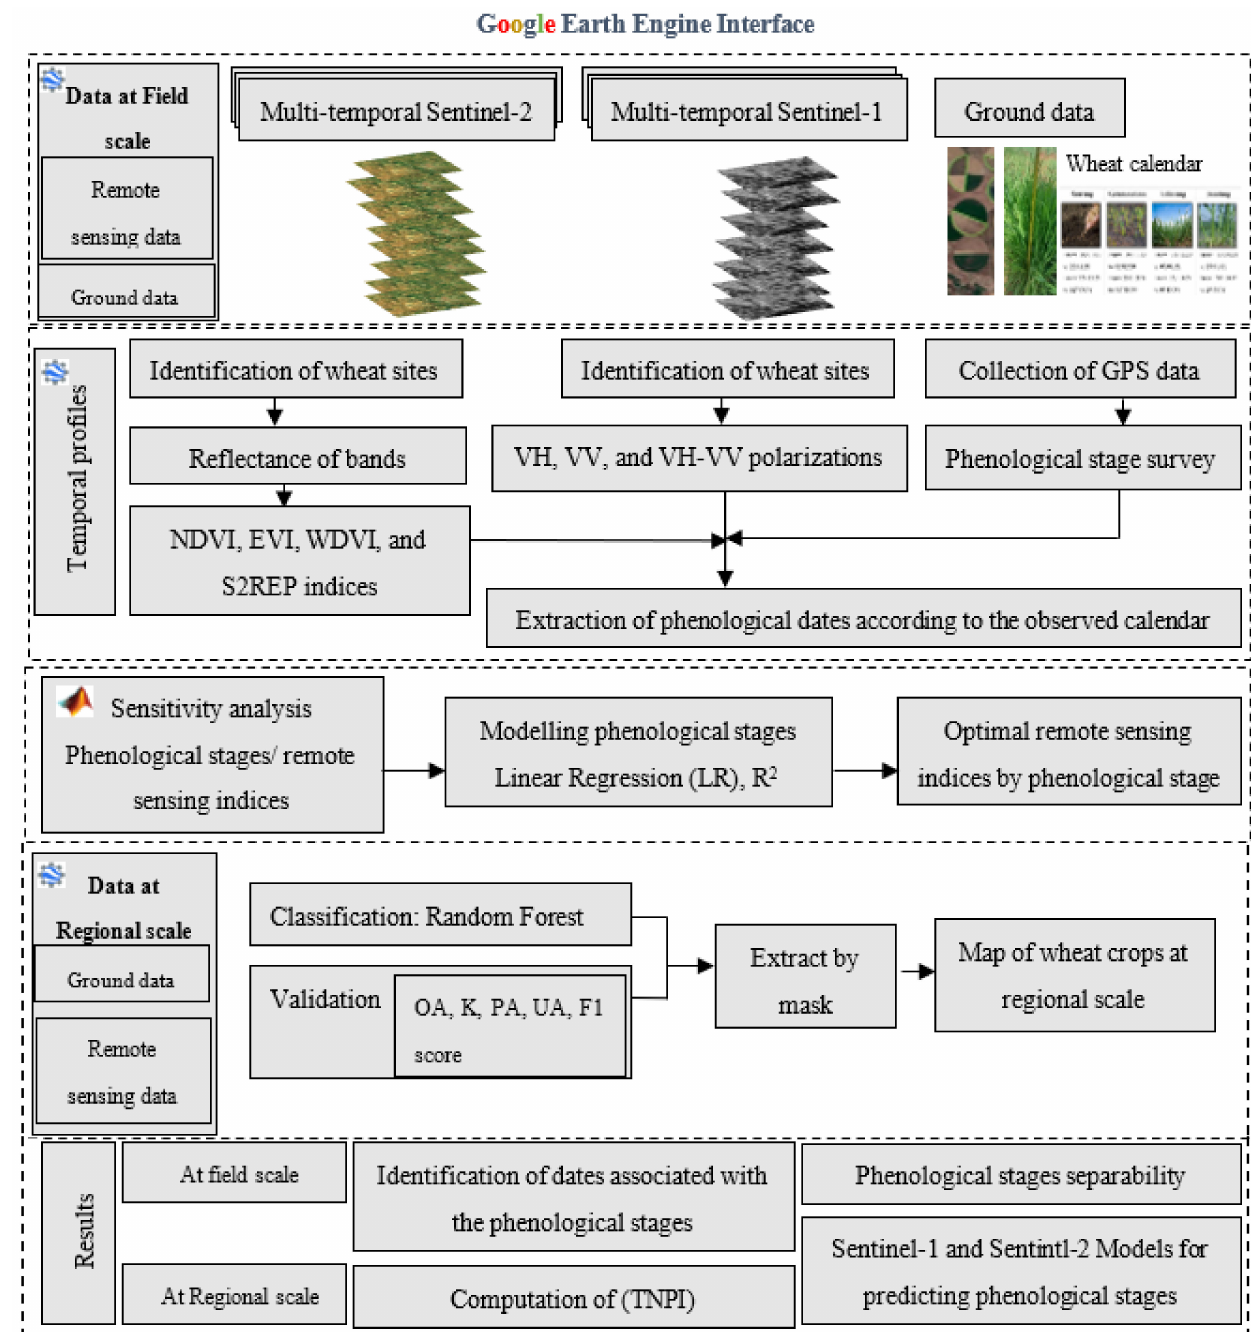
Figure 4. Flowchart of the proposed method to predict the phenological stages of wheat using the Google Earth